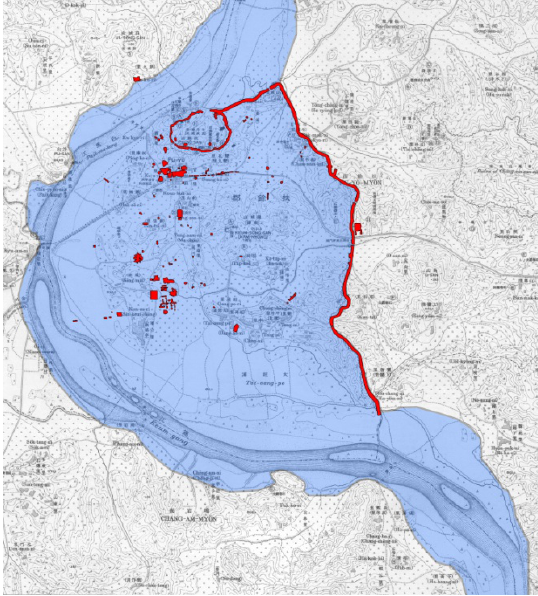
Figure 1. Base map and the restoration